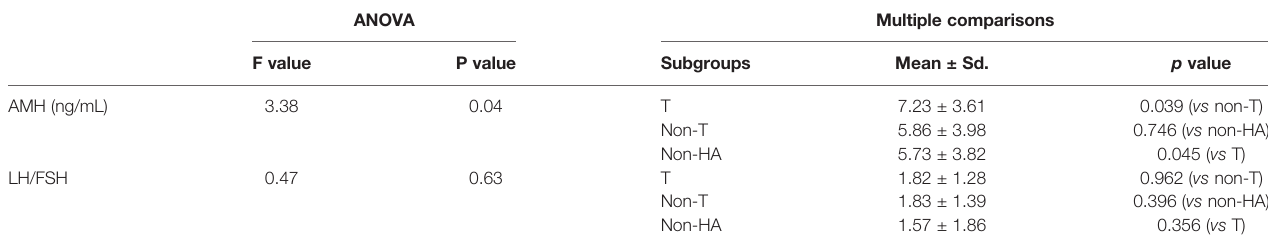
TABLE 4 | Comparison of the serum AMH and LH/FSH ratio between the three subgroups of the PCOS patients.